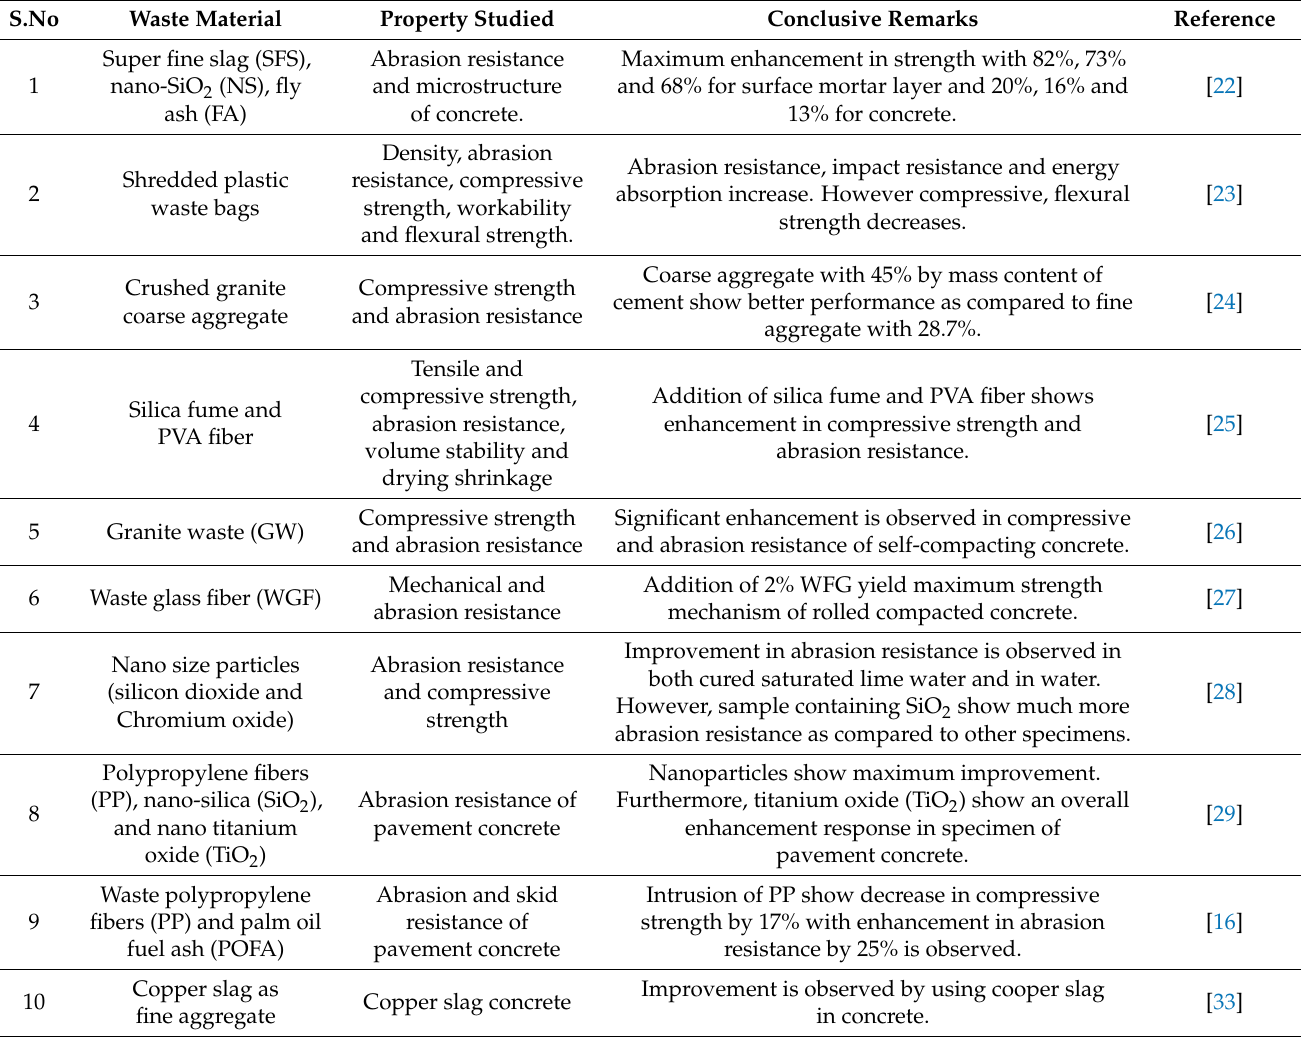
Table 1. Effect of waste material on properties of